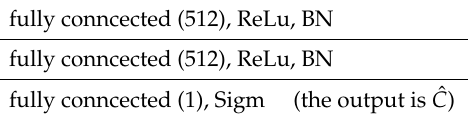
Table A5. Architecture of c ψ ( · )